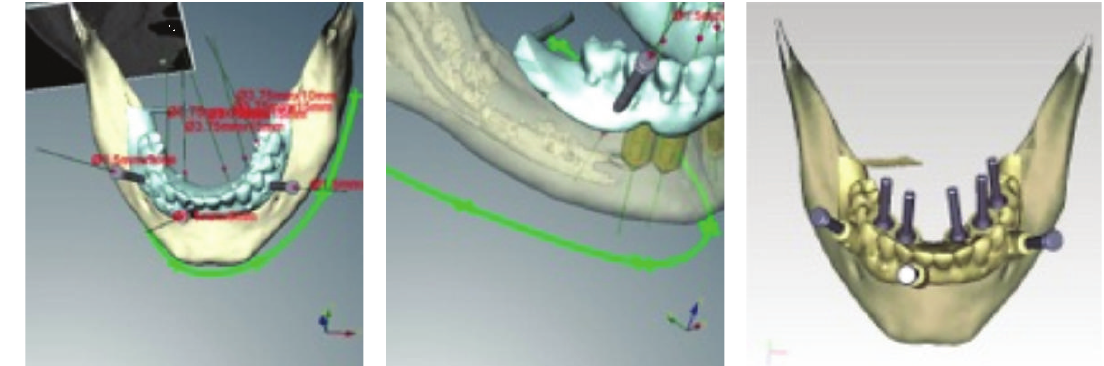
Figure 4: Representative images from the software with the driven prosthetic implants planned.